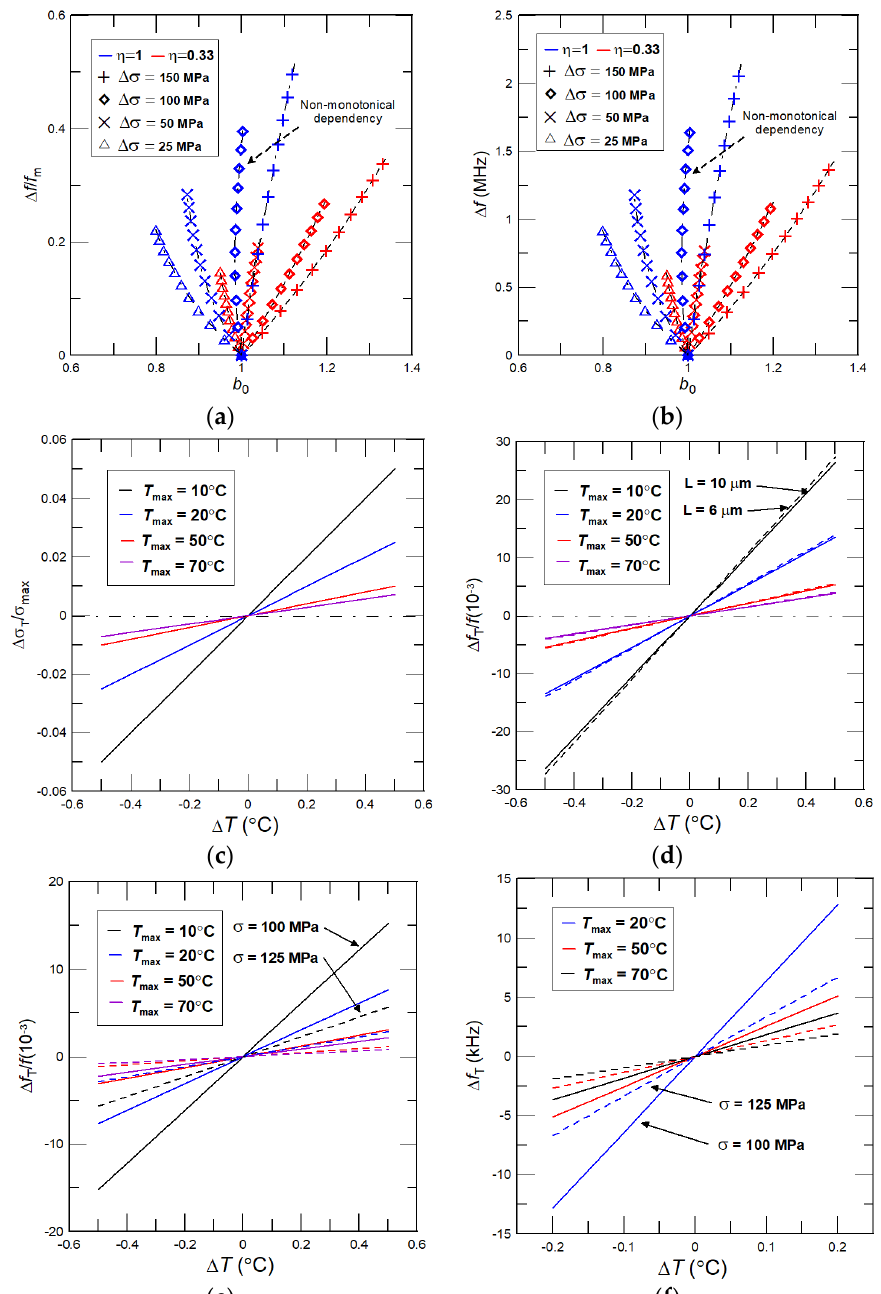
Figure 7. ( a ) Relative frequency shift Δ f / f m and ( b ) absolute frequency shift Δ f as function of b 0 for different moderate variations in the interlayer stress predicted for NiTi/Si nanocantilever of L = 10 μ m, η = 0.33, and 1, and σ m = 100 MPa; ( c ) dependency of the relative error in the interlayer internal stress Δ σ / σ max on uncertainties in temperature Δ T for different NiTi transformation temperature ranges T max ; dependency of error in the relative frequency shift Δ f T / f of the NiTi/Si nanocantilever on Δ T for different T max for ( d ) L = 10 and 6 μ m, σ = 100 MPa, and σ max = 100 MPa, and ( e ) L = 10 μ m, σ = 100, and 125 MPa, and σ max = 25 MPa; ( f ) dependency of error in Δ f T of the NiTi/Si nanocantilever of L = 10 μ m, σ = 100, and 125 MPa, and σ max = 25 MPa on Δ T for different T max ; for all cases σ m = 100 MPa.